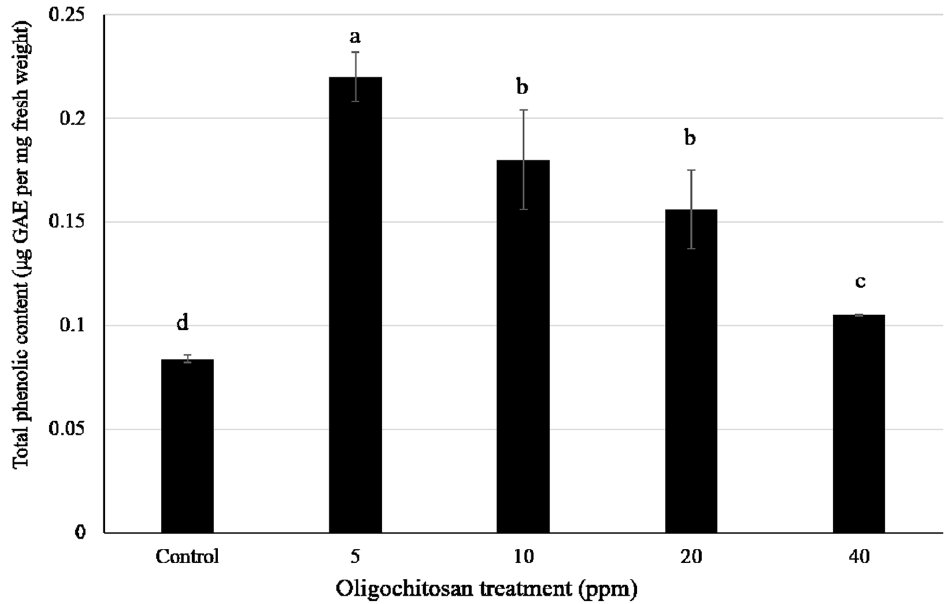
Figure 4. Total phenolic content in WRS extracts treated by oligochitosan O-80. Bars with di ff erent letters above them were significantly di ff erent according to Duncan’s multiple range test ( p < 0.05). Control is O-80 at 0 ppm.